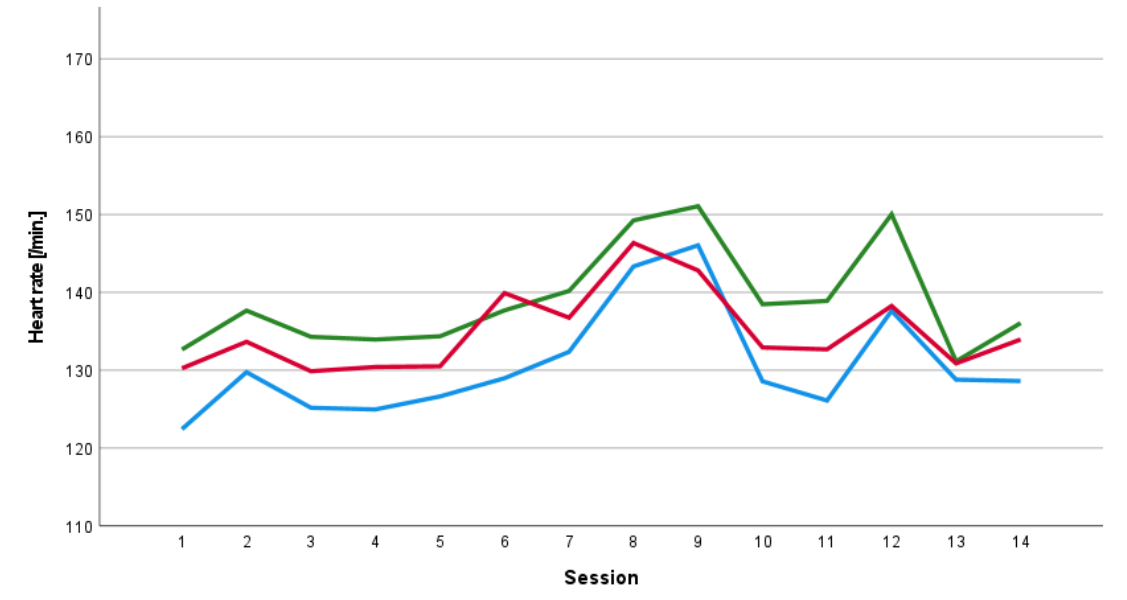
Figure 2. Baseline, peri- and post-therapy heart rate in physical therapy without music therapy. Blue line: mean baseline value, green line: mean peri-therapy value, red line: mean post-therapy value.